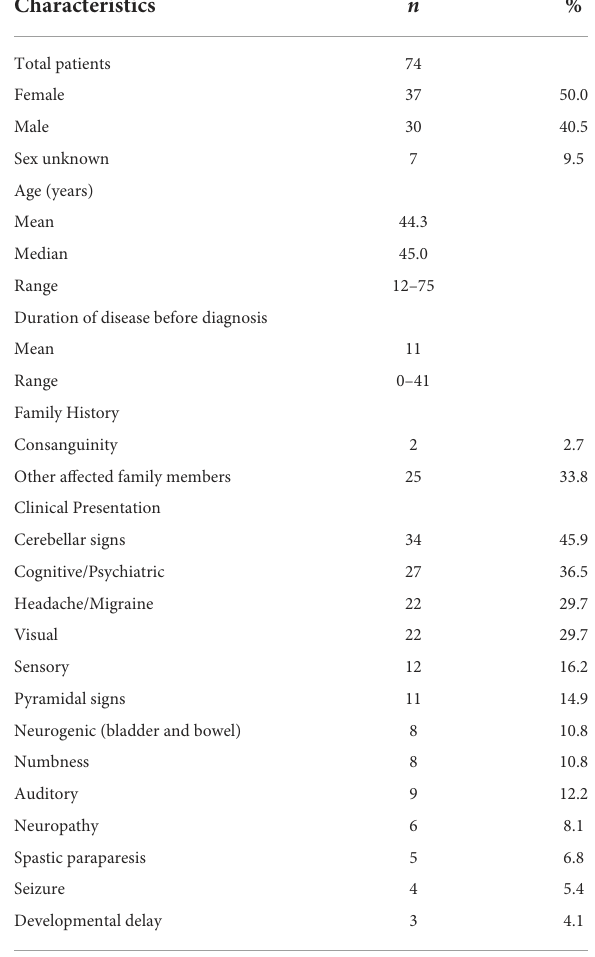
TABLE 1 Demographic and clinical features of the 74 subjects presented at the WM Rounds.